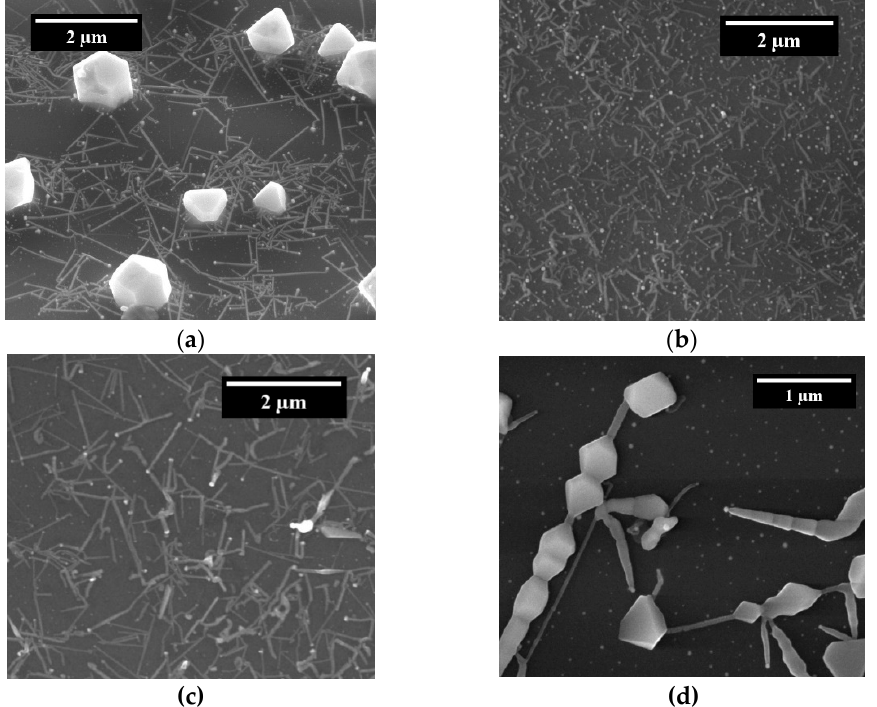
Figure 3. SEM images taken from samples A ( a ), B ( b ), C ( c ), and D ( d ), showing the resulting NW synthesis. The lighter spot at one end of the NWs indicates the gold droplet which acted as a cata- lyst. In addition, as a function of the oxygen concentration in the precursor and the temperature of the sample, sometimes either octahedra or nanorods can also be observed, as shown in ( a ) and ( d ).